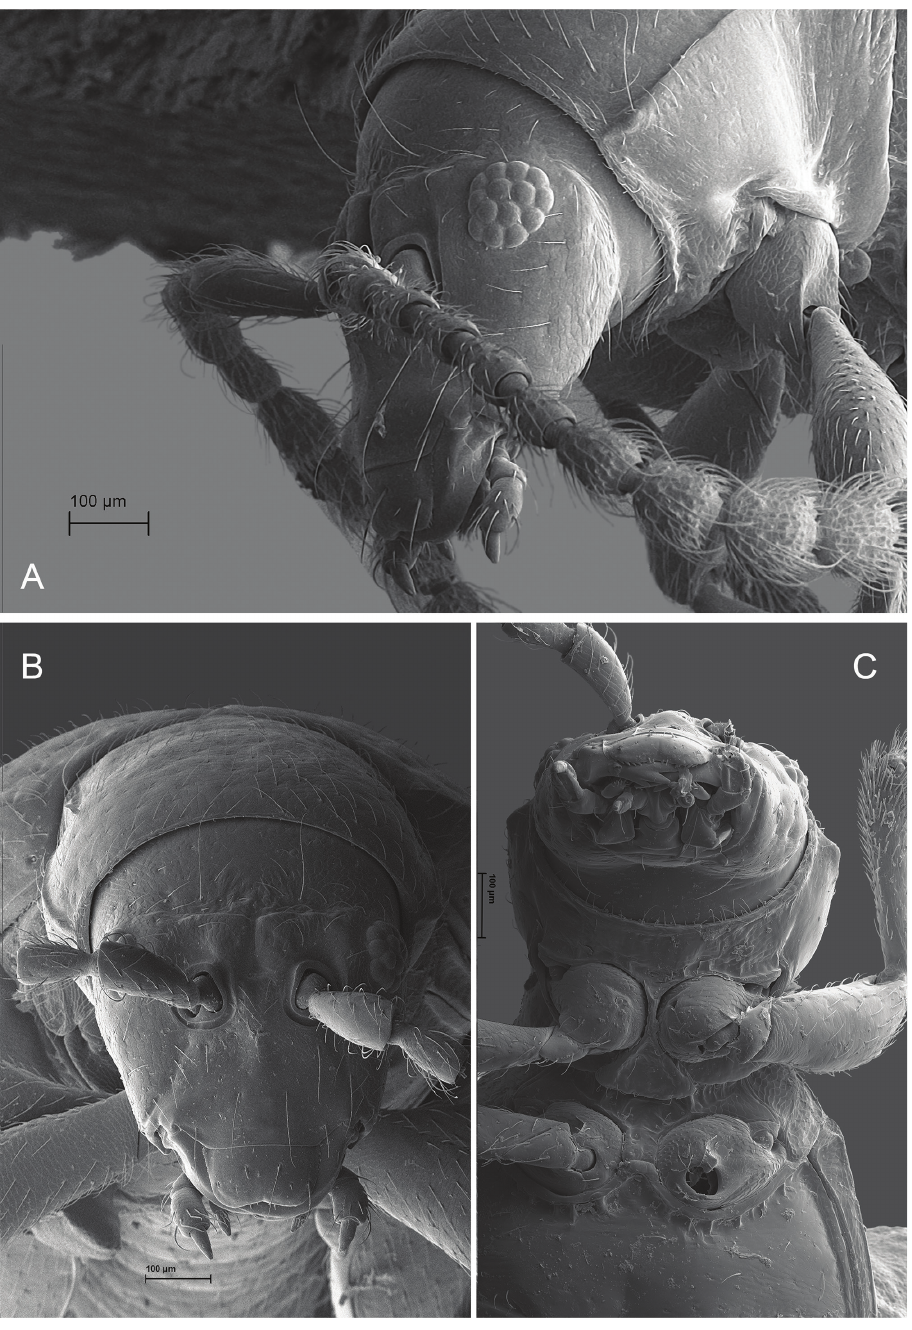
Figure 26. Andersonoplatus microoculus . A Head in lateral view B Head in frontal view C Head and pronotum in ventral